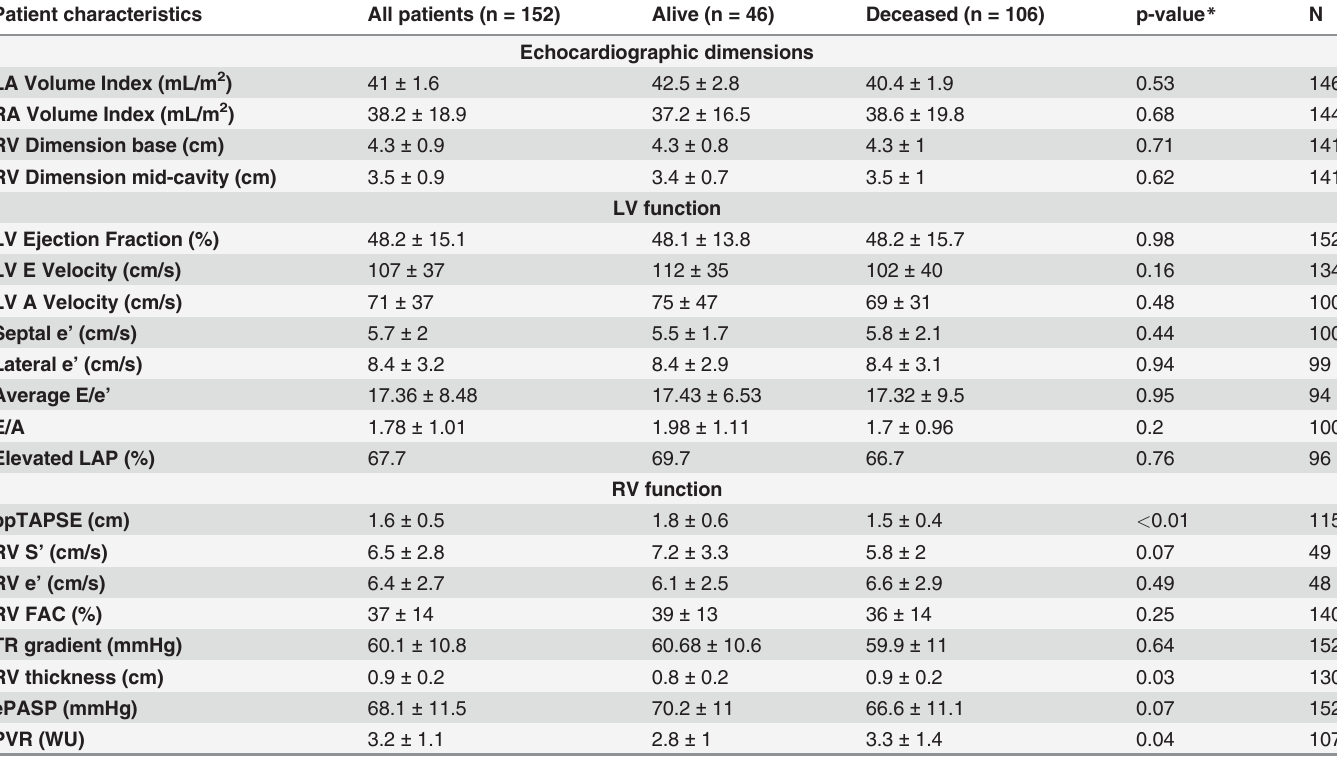
Table 2. Baseline Echocardiographic Characteristics. Patient